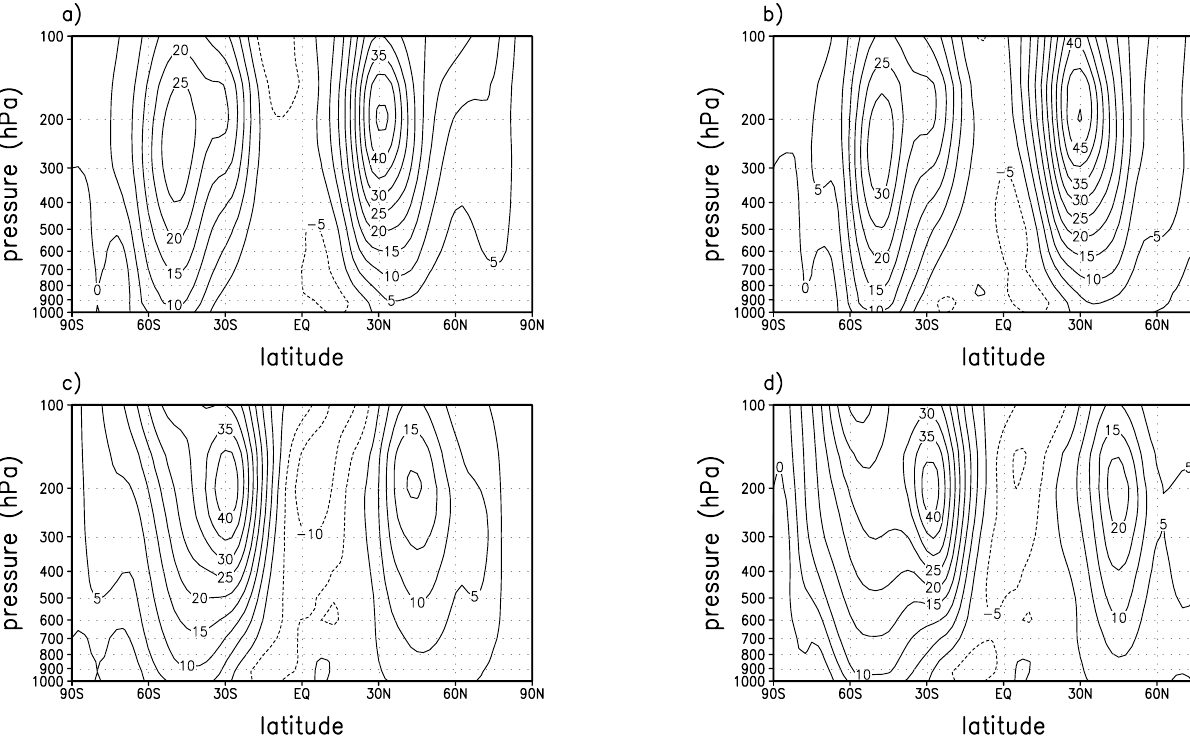
Fig. 13. Zonal wind for: (a) January 1996, (b) January 1998: (c) July 1995, and (d) July 1997. Units, ms − 1 .